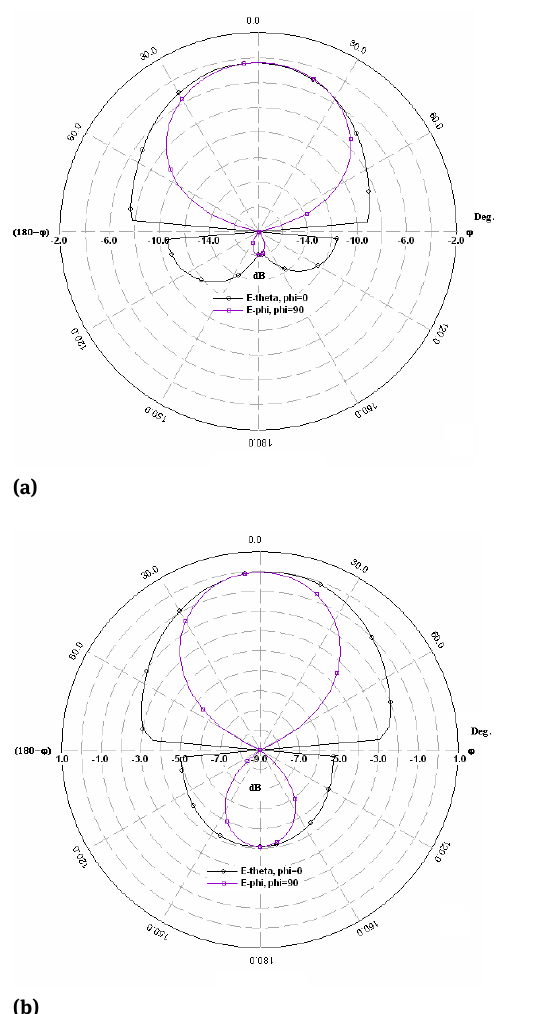
(b) Figure 11: Radiation Pattern of antenna (a) Lower resonance fre- quency (b) Upper resonance frequency (E theta , for phi=0 and phi=90